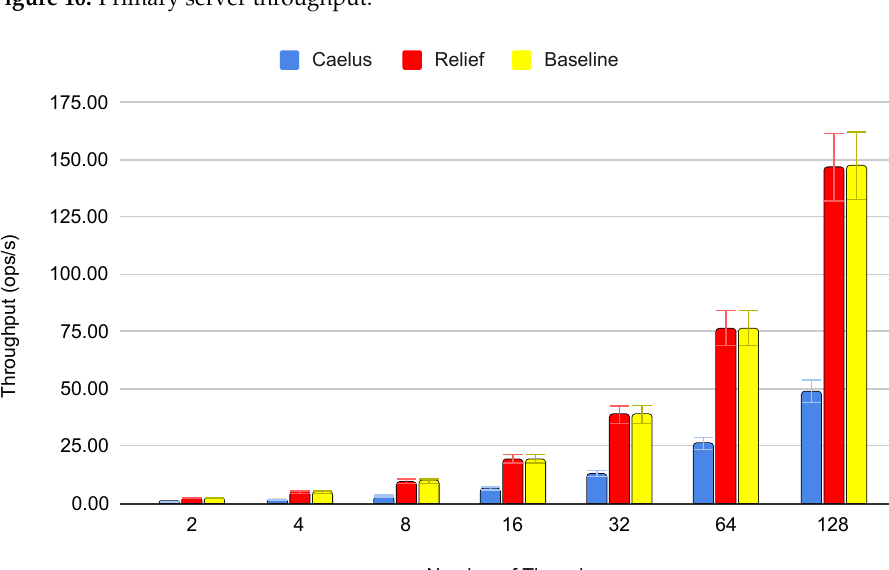
Figure 10. Primary server throughput.